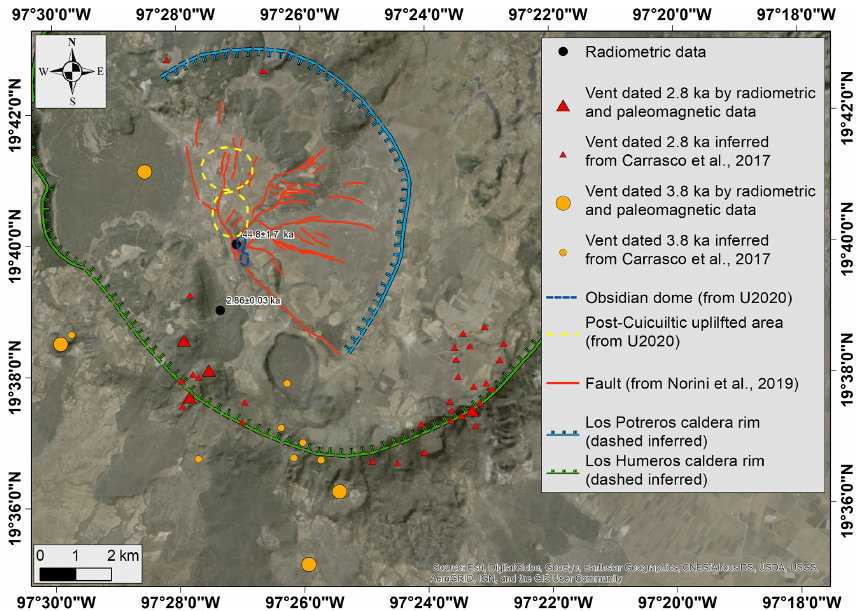
Figure 5. Map of the post-Cuicuiltic Member vents and ages based on radiometric data and palaeomagnetic analysis or inferred from geological maps (Carrasco-Núñez et al., 2017, 2018; Juárez-Arriaga et al., 2018). The post-Cuicuiltic Member uplifted areas and obsidian dome proposed by U2020 are also shown. Active faults are from Norini et al.